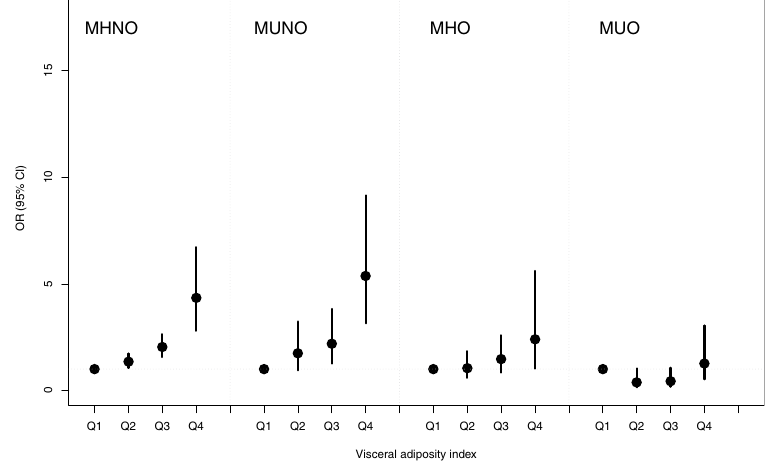
Figure 2. Adjusted odds ratios (OR) and 95% confidence intervals (CI) for hyperuricemia risk associated with visceral obesity index within each metabolic obesity phenotype defined by ATP-III criteria. Vertical bars are 95% CIs. The adjusted OR was obtained from Model 3: adjusted for age, sex, urban/rural resident, smoking status, alcohol status, white blood cell, total cholesterol, blood pressure, glucose and hs-CRP. Abbreviations : ATP-III, the Adult Treatment Panel-III; MHNO, metabolically healthy non-obese; MUNO, metabolically unhealthy non-obese; MHO, metabolically healthy obese; and MUO, metabolically unhealthy obese.